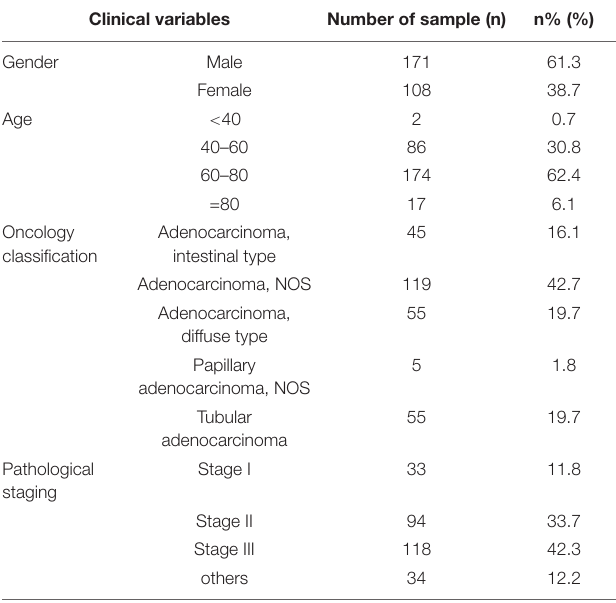
TABLE 1 | Statistics of clinical information of included 279 GA patients. Clinical